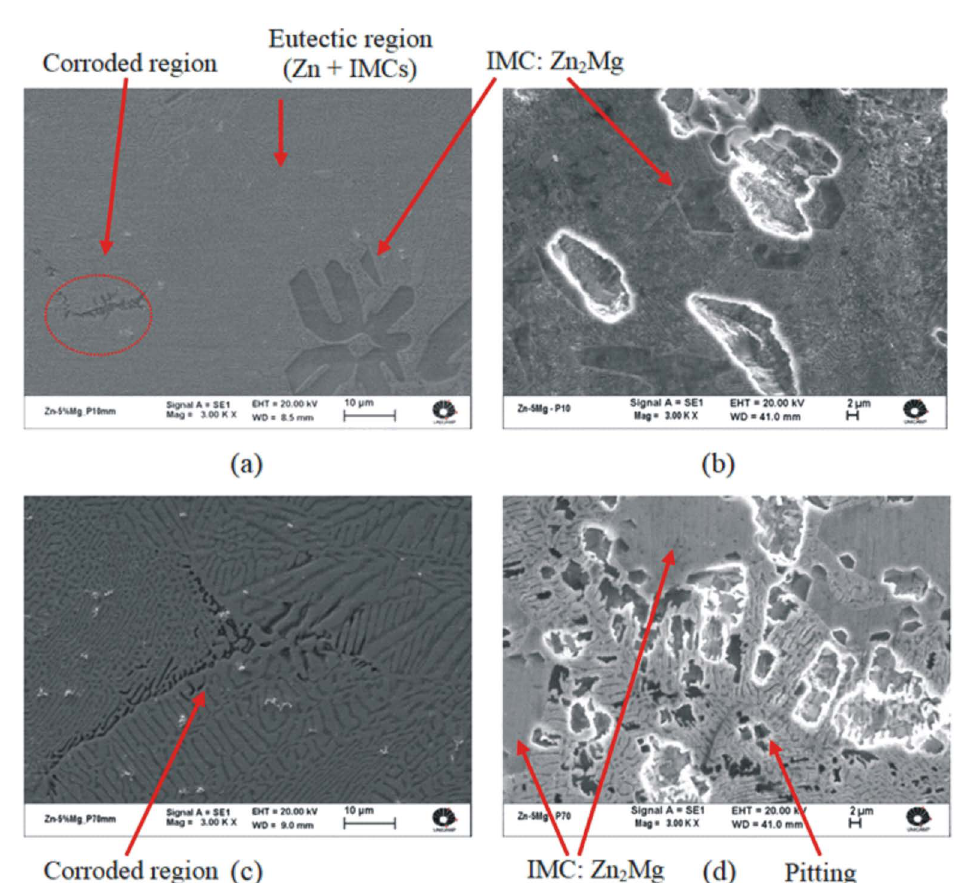
Figure 11. SEM images after corrosion tests: (a) and (b) sample P_10mm and (c) and (d) sample